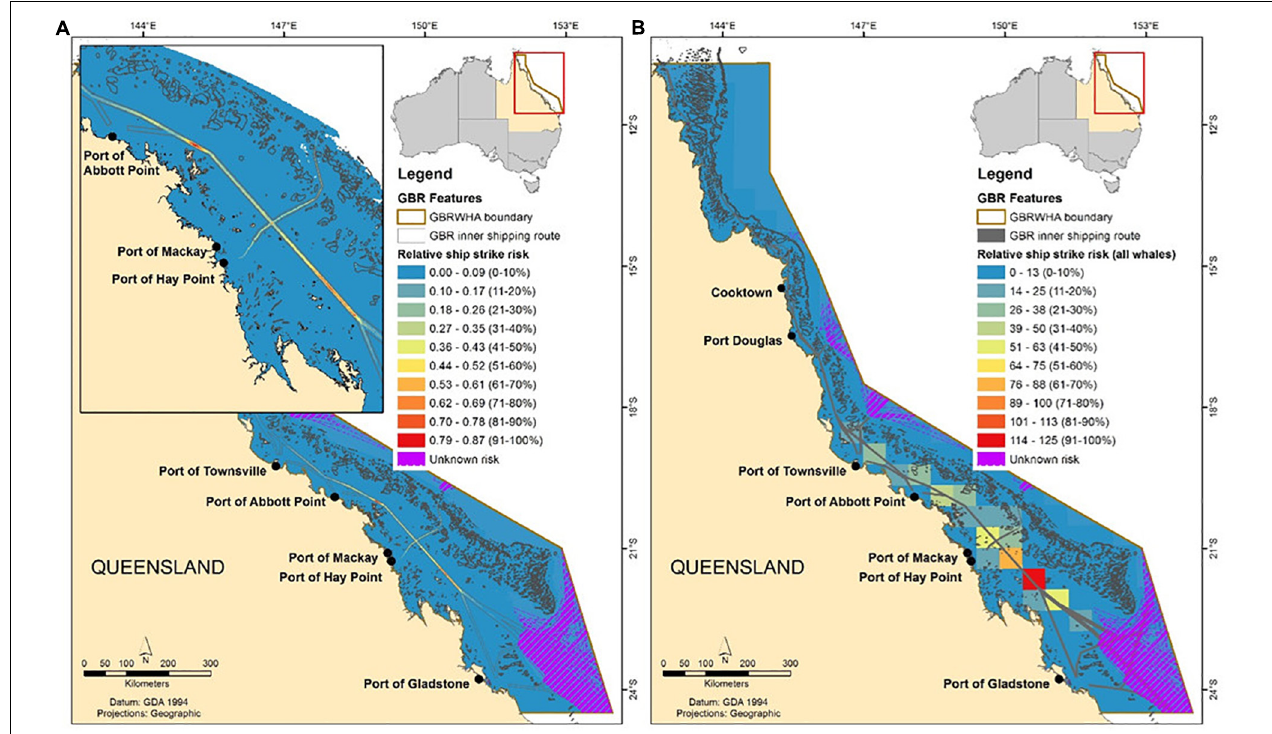
FIGURE 4 | Relative ship strike risk for all humpback whale groups in the GBRWHA based on the 2012 whale model and 2016 shipping data at (A) 1 × 1 km and (B) 50 × 50 km grid cell resolution.